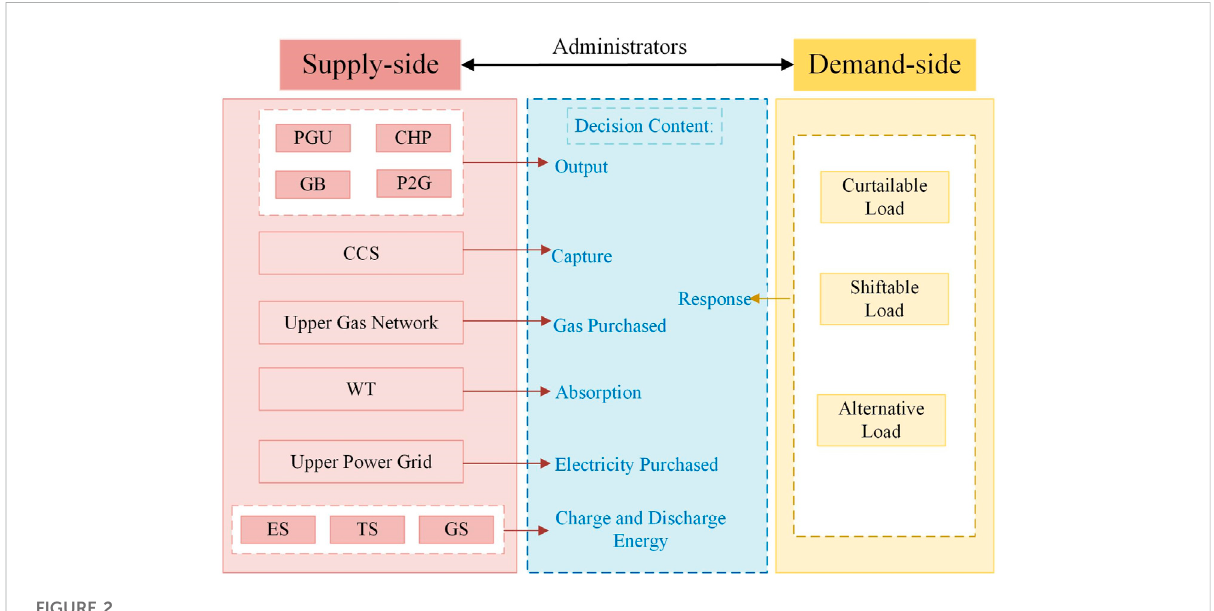
FIGURE 2 Demand response mechanism